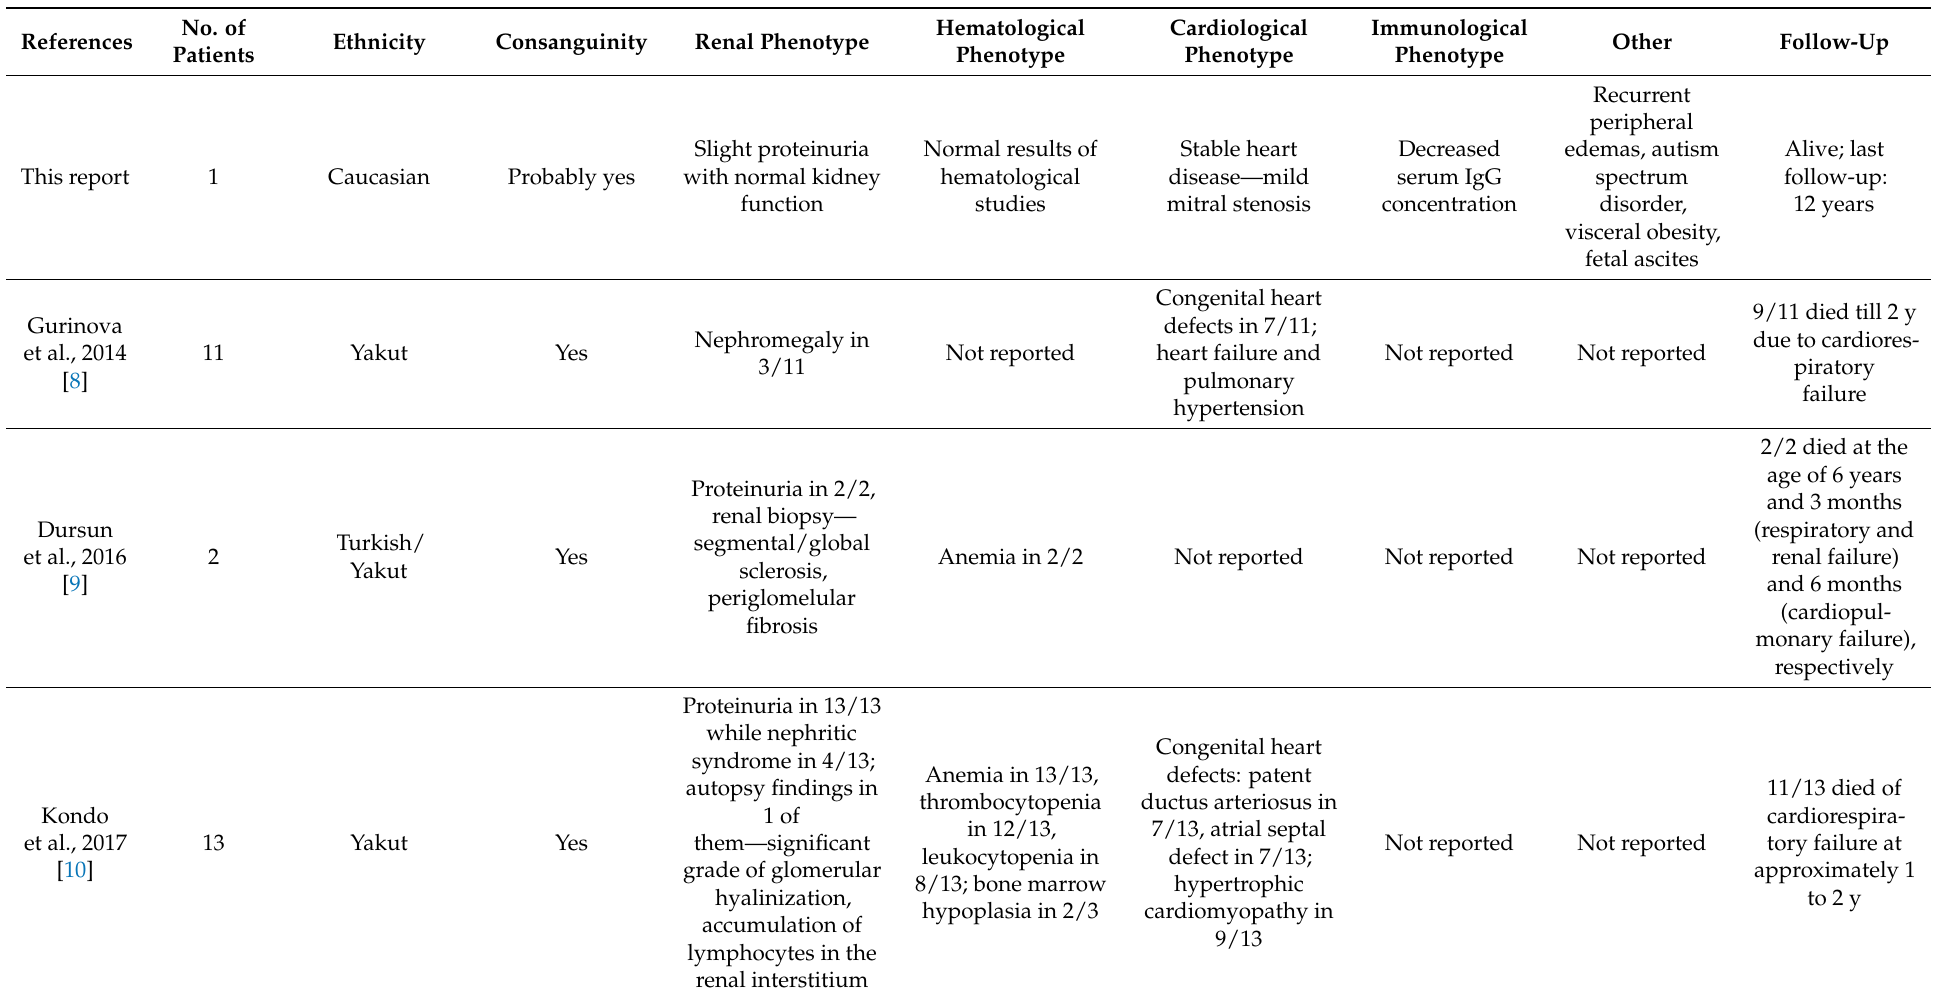
Table 2. Comparison between our patient and other MPS-PS described